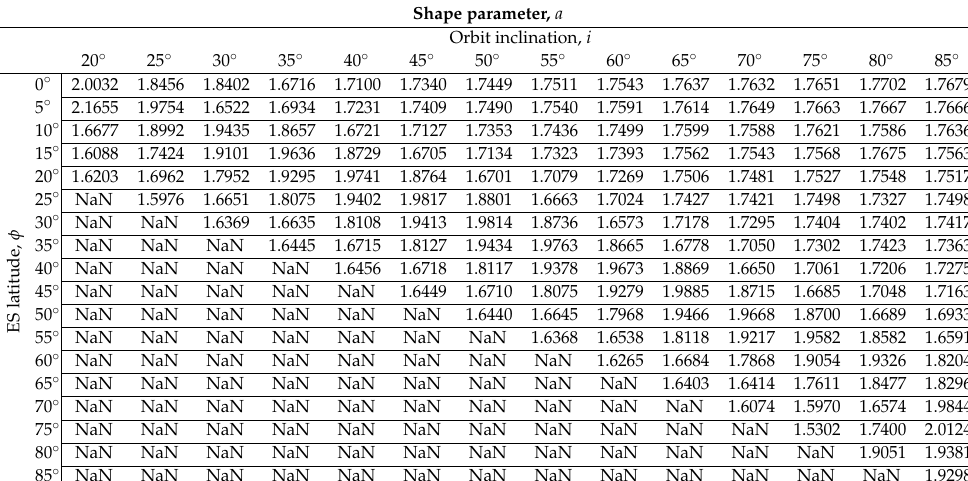
Table A3. Shape, a , and rate, b parameter for f Θ ( θ ) and F Θ ( θ ) for h k = 1400 km.